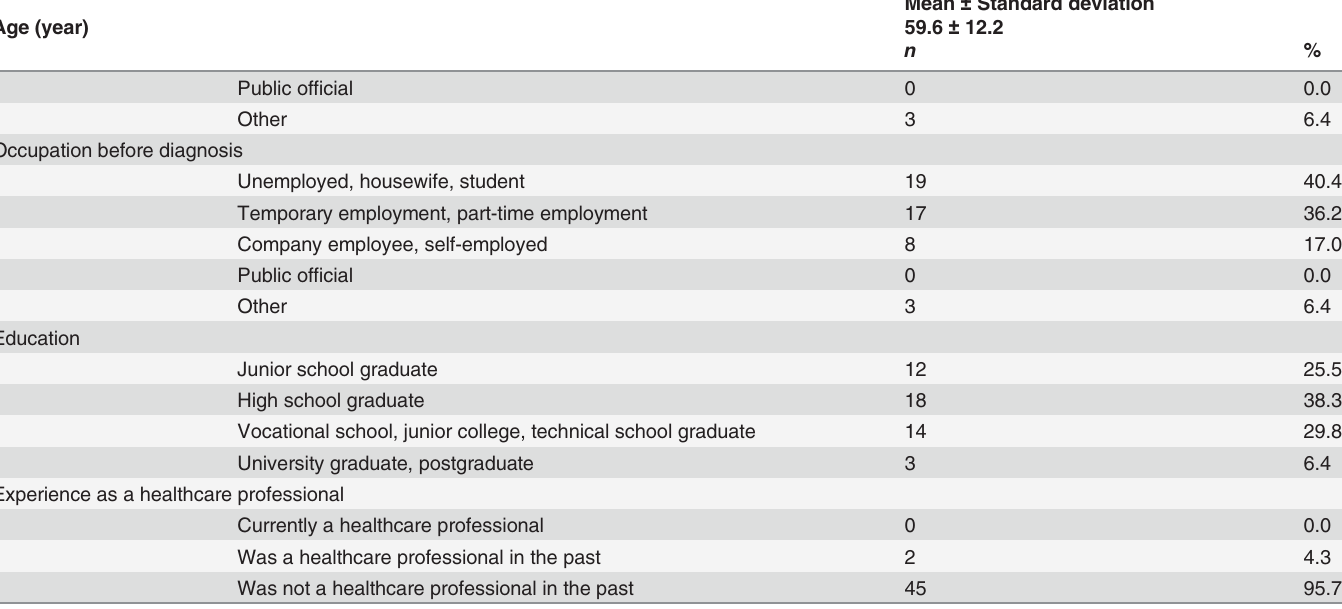
PS: performance status, HER2: human epidermal growth factor receptor type 2, ER: estrogen receptor, PgR: progesterone receptor, EC: epirubicin/